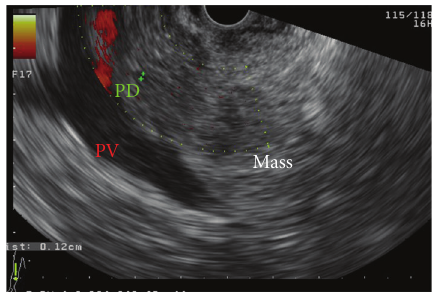
Figure 2: Linear EUS showing a markedly inhomogeneous pancre- atic body parenchyma. The ultrasound wave was unable to delineate anatomical structures corresponding to either the main or the secondary pancreatic